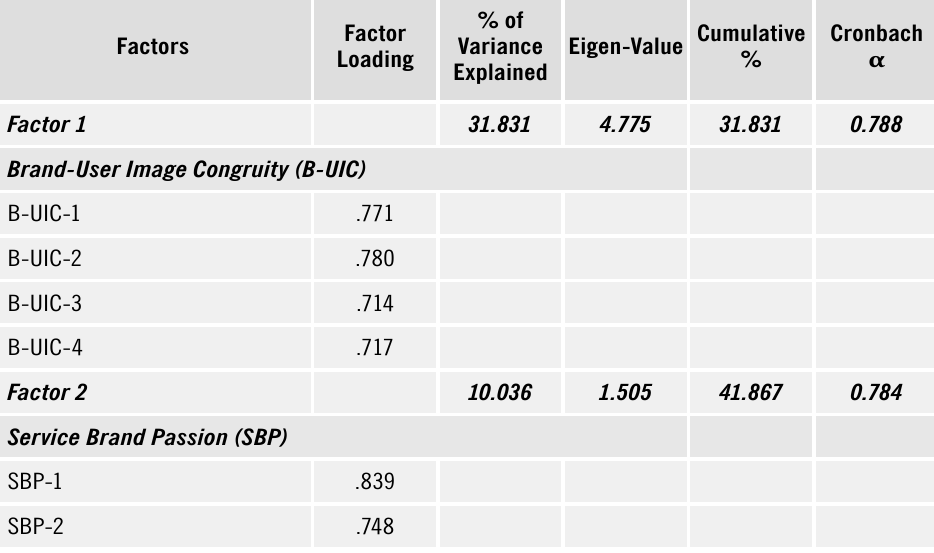
Table 1. Factor loadings of exploratory factor analysis for the five-factor model